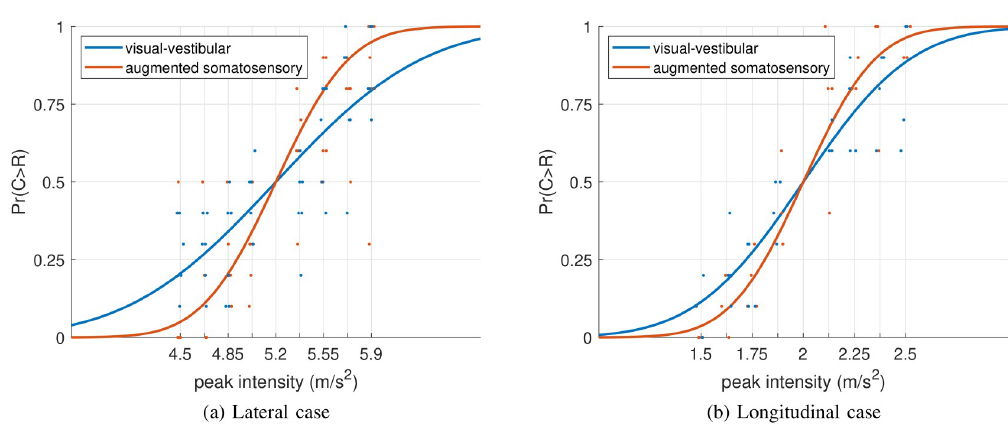
Fig 6. Data acquired in the 2IFC task for the lateral (left panel, (a)) and longitudinal (right panel (b)) cases. Light blue and orange dots represent the proportion of trials where the comparison stimulus was judged larger than the reference by an individual participant for each comparison stimulus intensity, for responses collected in the M and S conditions, respectively. A small amount of random noise was added to the x-coordinate of individual data points to improve their visibility. Lines are the four fitted psychometric functions obtained through model (2). The results suggest that active somatosensory stimulation increases discrimination sensitivity.